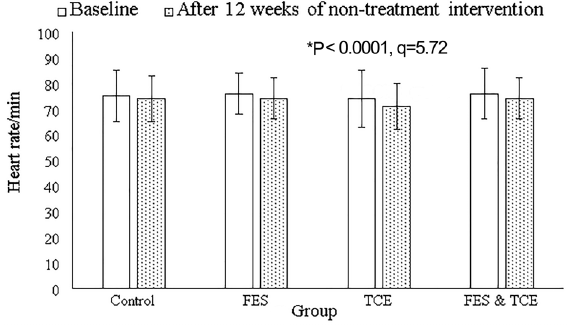
Figure 4. Effects of non-pharmacological interventions on heart rate. RM-MANOVA followed by Tukey ’ s post hoc test was used for statistical analysis. Data are reported as means ± SD at baseline and after 12 weeks of intervention. The evaluators of the institute were blinded regarding the interventions. *P o 0.05 compared to the control group. FES: functional electrical stimulation of lower limb muscles; TCE: Tai Chi